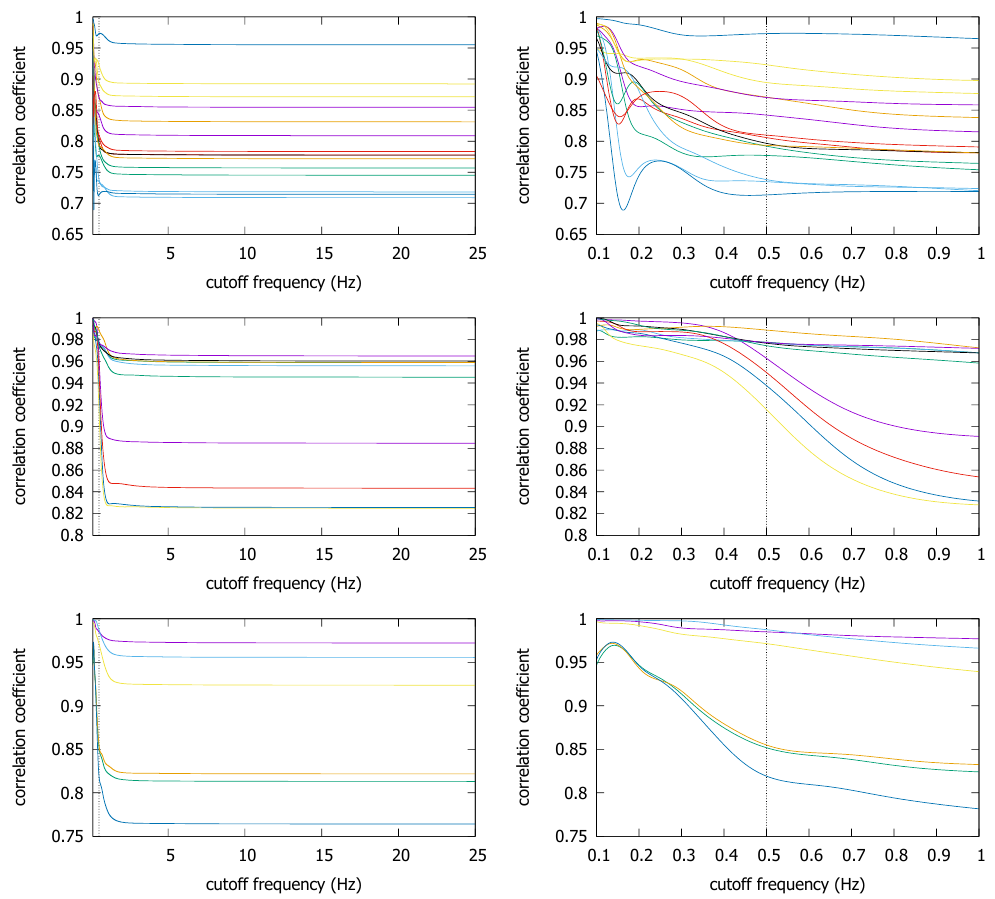
Figure 10. ρ max for coexistent traces in the Illinois dataset: CSL ( top ), Loomis ( middle ), Talbot ( bottom